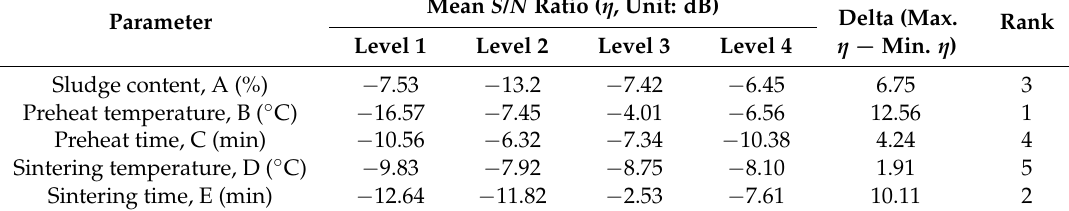
Table 8. S / N response table for water absorption.